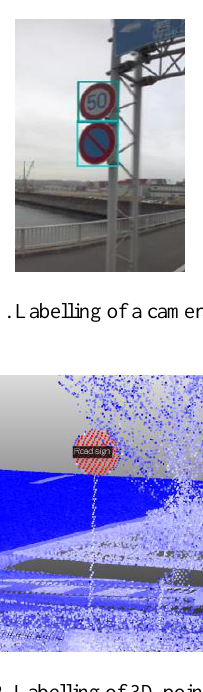
Figure 2. Labelling of 3D point